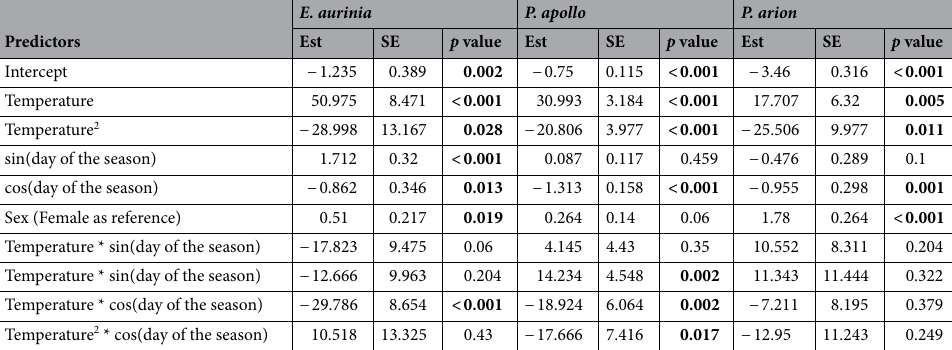
Table 2. Predictors of species presence, models output for each species. Estimate, CI, and p values from a GLM with a binomial error structure. Significant values are in bold.